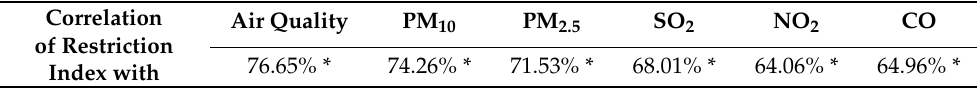
Table 4. Correlation of restriction index with air pollutants (US EPA standard).